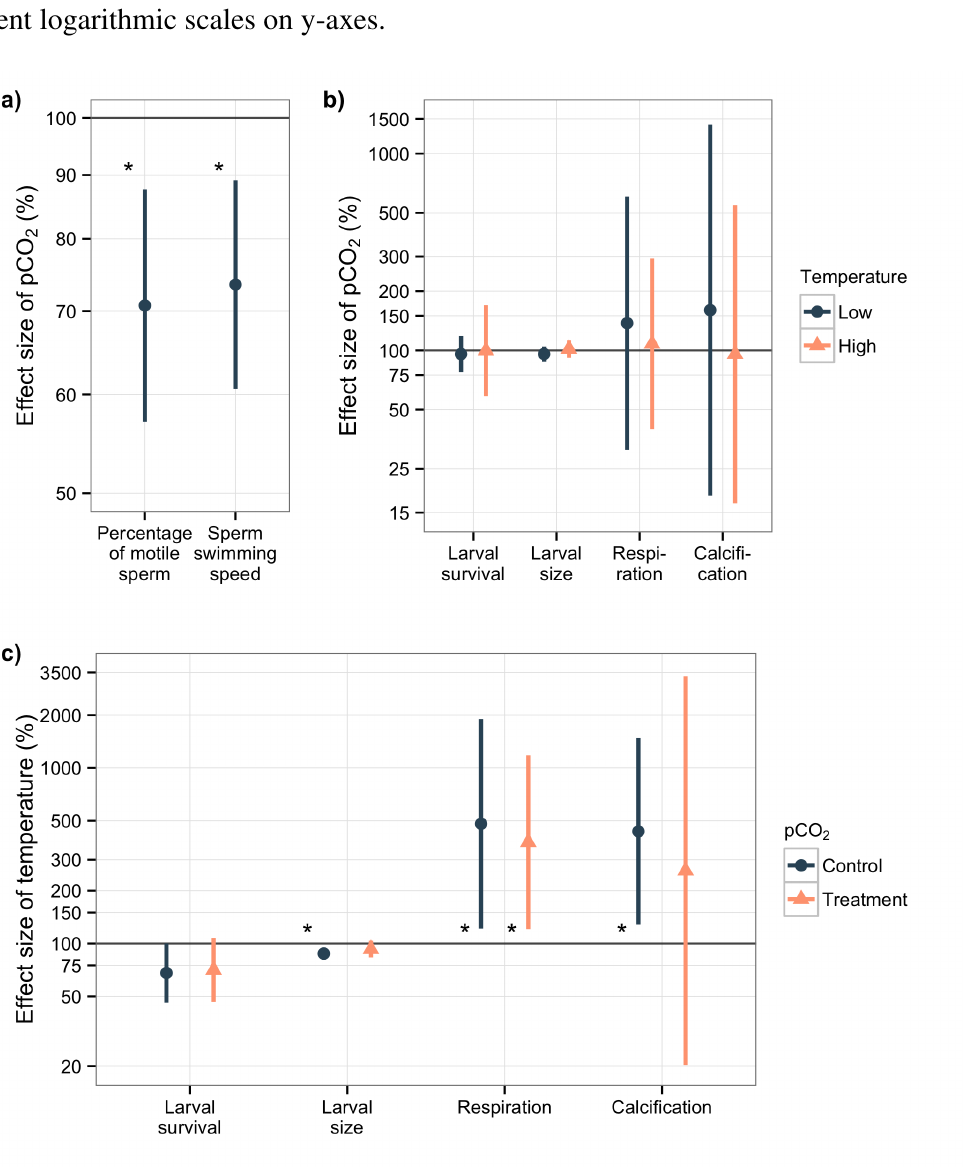
Figure 3. Effect size (R) for a range of sperm activity and early life-stage parameters of M. galloprovincialis : ( a ) sperm motility and sperm swimming speed between treatment and control p CO at control temperature; ( b ) larval parameters (survival rate and size 58 h after 2 fertilization (a.f), larval respiration rate 51–57 h a.f., and calcification rate 48–55 h a.f.) between treatment and control p CO ; and ( c ) larval parameters between treatment and 2 control temperature. Dots and triangles represent mean effect sizes ( ¯ R ), and error bars give the 95% CIs. CIs crossing the black line at 100% indicate no significant difference between p CO treatment and control ( a and b ) or high and low temperature treatments 2 ( c ). Values less than 100% indicate that either the elevated p CO or the high temperature 2 treatment resulted in lower values compared to the respective control. Asterisks (*) indicate statistically significant effects, i.e., when the 95% CIs did not cross the 100% line. Note the different logarithmic scales on